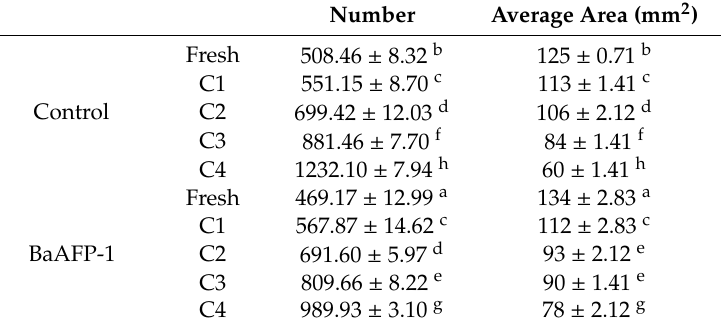
Figure 5. Convention, identification and analysis of the image of bread pore distribution. Table 2. Number and average area of bread pore obtained by image analysis.